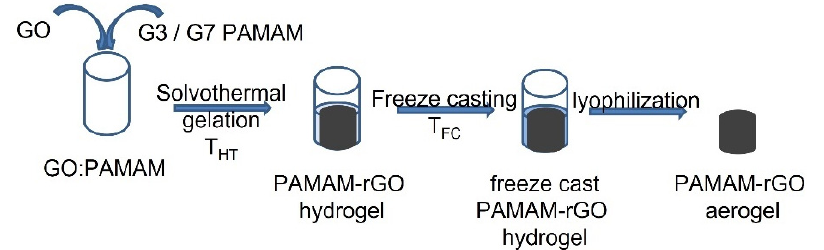
Figure 1. Scheme of the synthesis procedure.